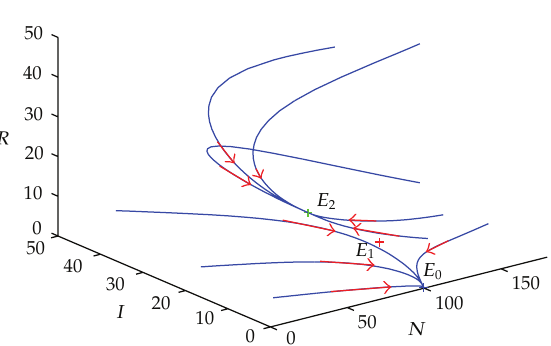
Figure 4: The phase diagram of system (cid:5) 1.4 (cid:6) when I 0 (cid:7) 5, A (cid:7) 80, β 1 (cid:7) 0 . 015, β 2 (cid:7) 0 . 001, γ (cid:7) 0 . 01, d (cid:7) 0 . 8, (cid:7) 0 . 8607, p (cid:7) 0 . 6589, p (cid:7) 1 . 1016, R (cid:7) 0 . (cid:4) (cid:7) 0 . 01, r (cid:7) 1, p 0 1 2 0